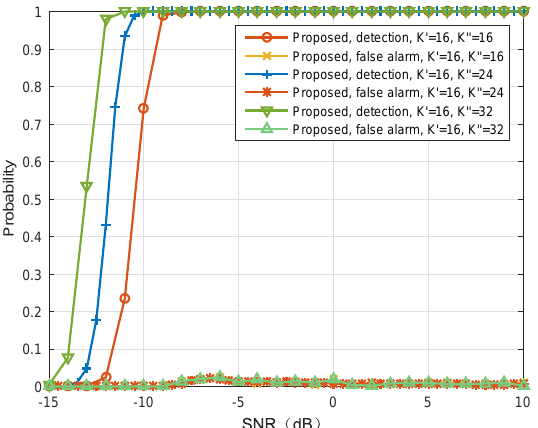
Figure 9. Effect of eavesdropper’s signal and legitimate user’s antenna number on detection = 10, M = 128 and K = 16.The parameter K (cid:48) represents the performance when p b = 1, T M number of antennas of the legitimate user, and the parameter K (cid:48)(cid:48) represents the number of antennas of the